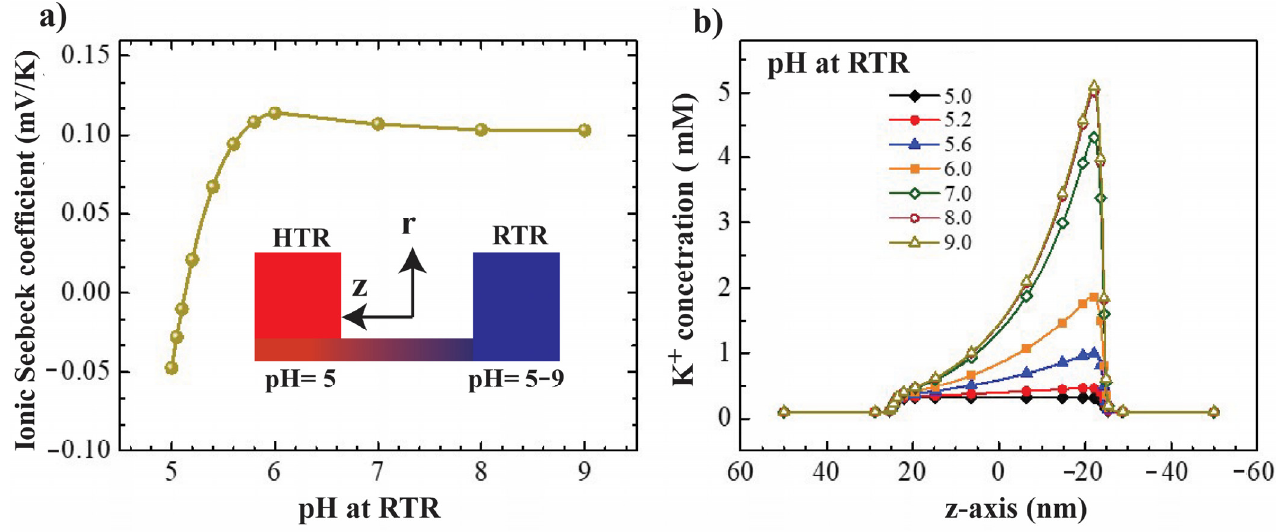
Figure 6. ( a ) Ionic Seebeck coefficient as a function of pH level at RTR. ( b ) K + concentrations along the centreline of nanopore with the pH level at RTR varies from 5.0 to 9.0. Note that the pH level of HTR is fixed at 5.0.